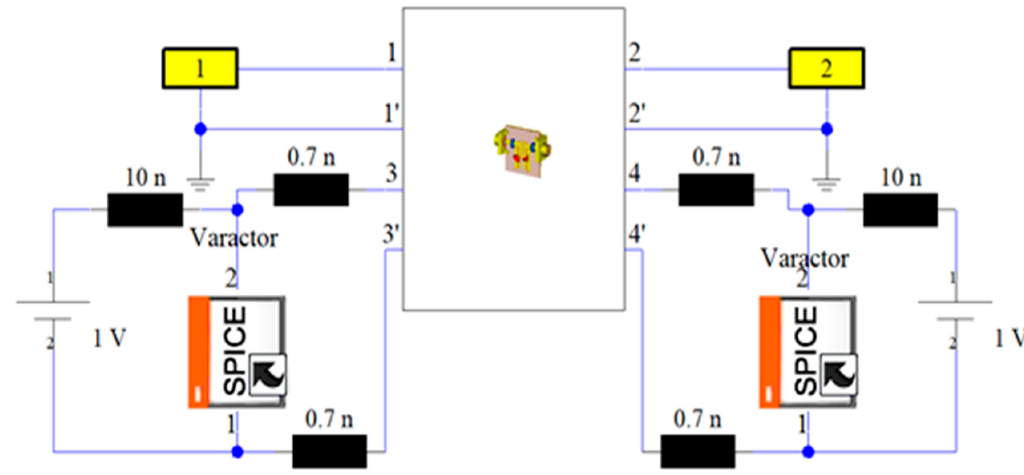
Figure 8. Integrating the RF reconfigurable microstrip filter with the DC circuit and the SPICE representation for the varactors.